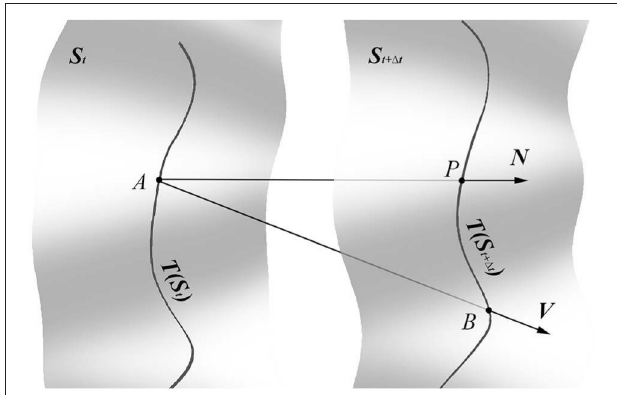
FIGURE 3 | Geometric interpretation of the invariant time derivative ˙∇ applied to invariant tensor field T . A is an arbitrarily chosen point on the S t surface so that it lies on the T ( S t ) curve. B is the corresponding point on the S t 1 t + surface. P is the point where the S t surface normal, applied on the point A , intersects the surface S t 1 t . For infinitely small 1 t AB ≈ V 1 t and + AP V N 1 t . According to the geometric construction the tensor field T at ≈ · T ( A ) 1 t ∂ T /∂ t , while T ( B ) can be the point B can be estimated as T ( B ) ≈ + T ( P ) T , where 1 tV i estimated by the covariant surface derivative T ( B ) ≈ + ∇ i T shows rate of change in T along the directed distance BP 1 tV i on the ∇ i ≈ surface S t 1 t +